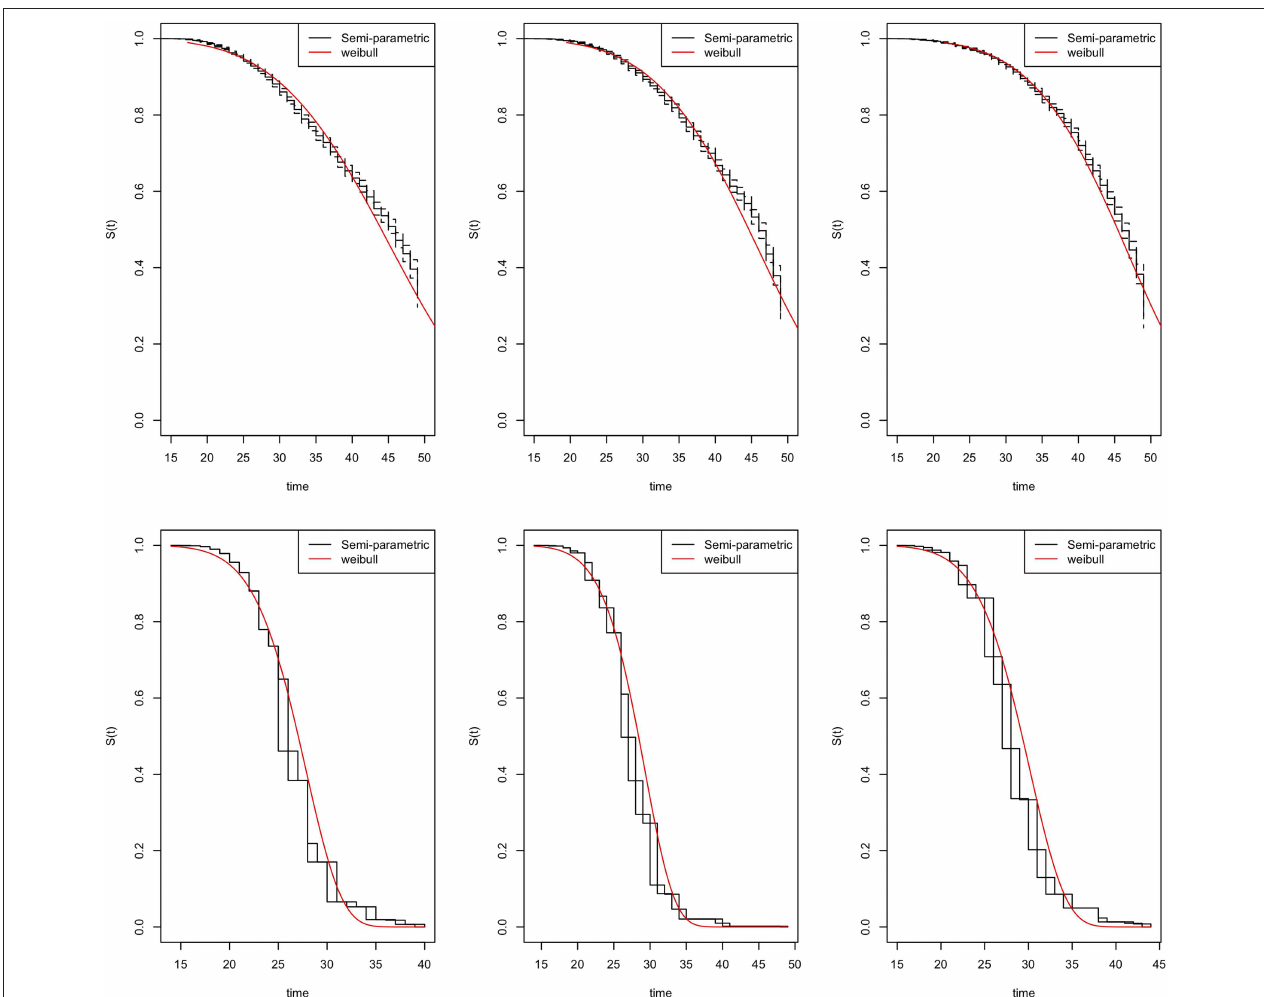
FIGURE 3 | Goodness-of-fit tests for the Zimbabwe DHS 2005–06 (left column), 2010–11 (middle column), and 2015 (right column). Model 1 (top row) and Model 2 (bottom row).